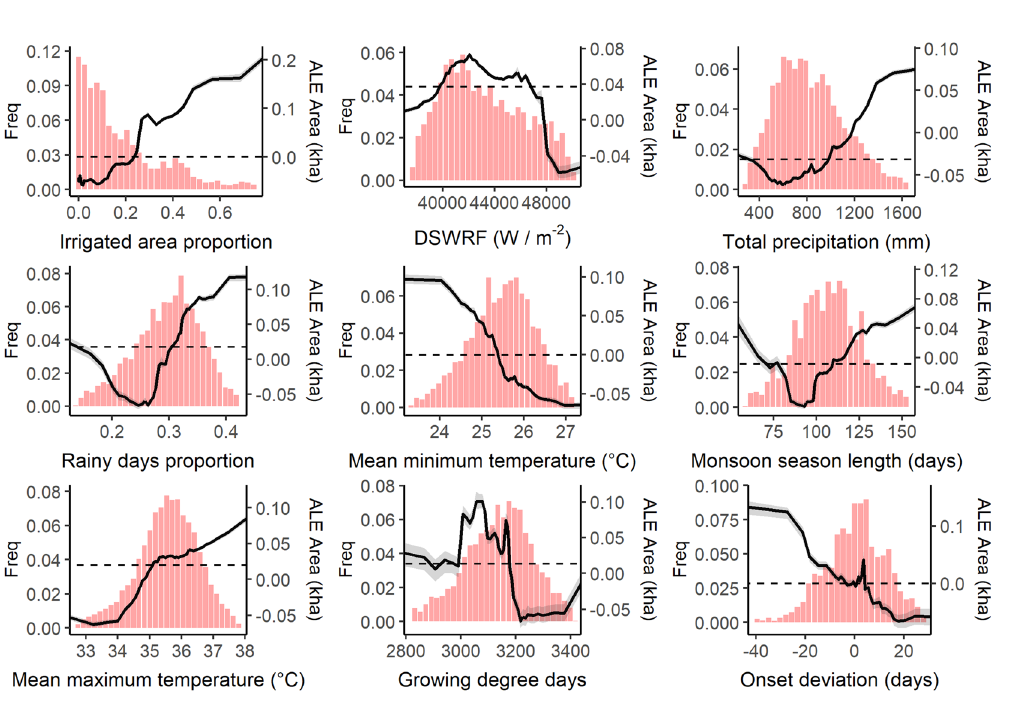
Figure 6. Accumulated Local Effects (ALE) plots of the harvested area anomaly response model for each predictor variable. 100 random forest models were run with different seeds, solid black lines represent mean ALE and ribbons represent 95th percentile ALE. Histograms show the distribution of the 98th percentile of predictor data in the original full dataset prior to sub-sampling for the random forest modelling. Note that y-axis ALE values are contingent on input data and are not directly comparable. Y axis scale varies between each sub-plot to highlight response curve